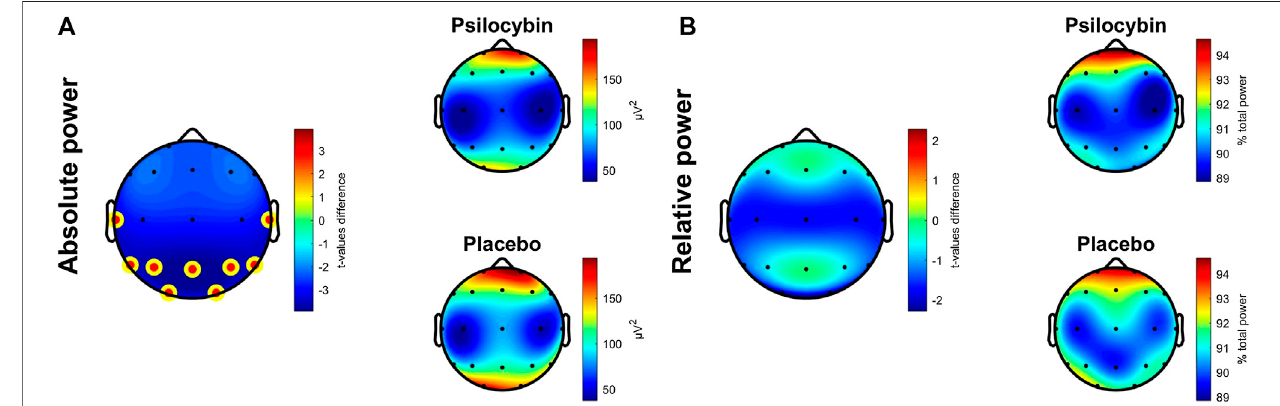
FIGURE1|(A) Topographicplotsofdifferences int-values (Psilocybin – Placebo)inabsolutedeltapower (left) and averageabsolutedeltapower inpsilocybin (left top) and placebo (left bottom) condition during the fi rst SWS cycle, signi fi cant over averaged parietal, temporal and occipital derivations (corrected). (B) Topographic plots as described in (A) for relative delta power with all differences non-signi fi cant. The yellow-red dot denotes areas signi fi cant at p < 0.01 (corrected).